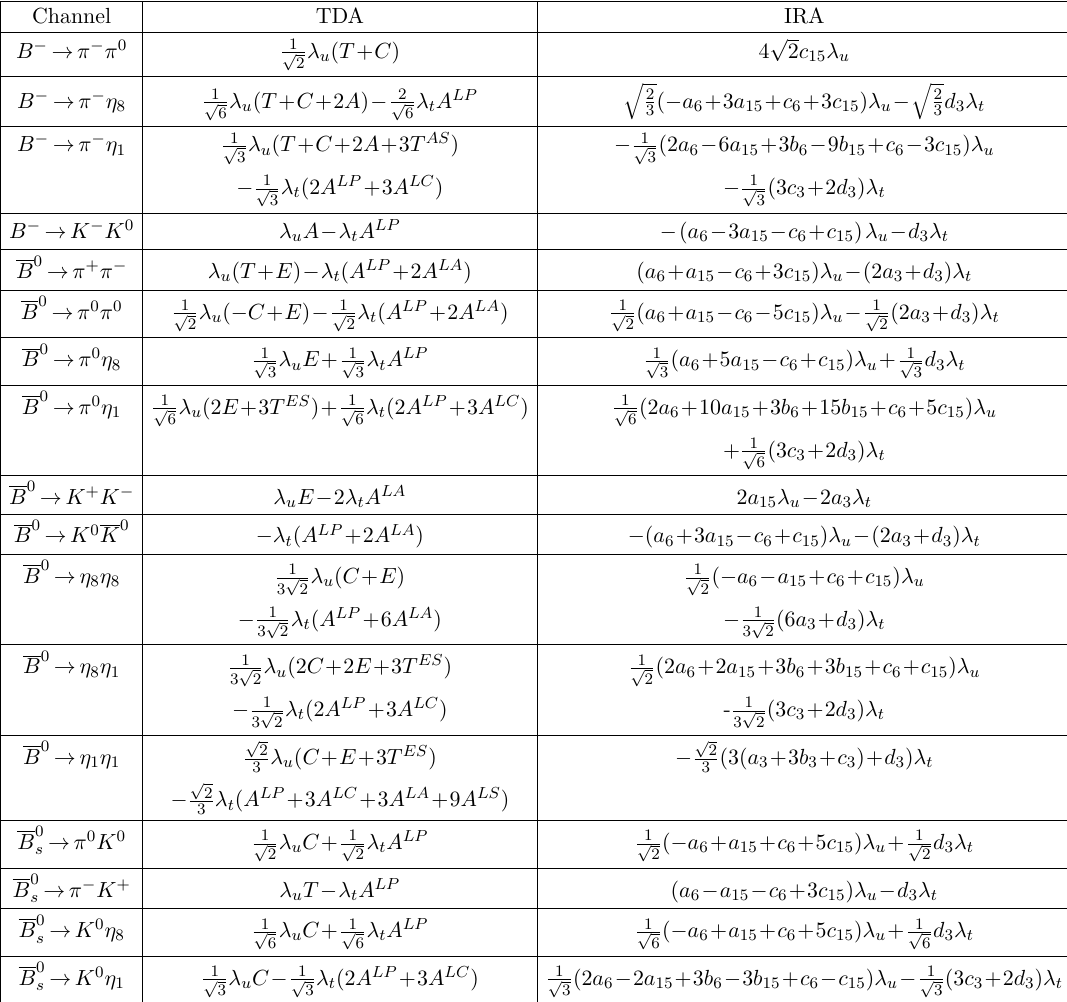
Table 3 . Decay amplitudes of the B → PP decays induced by the b − d